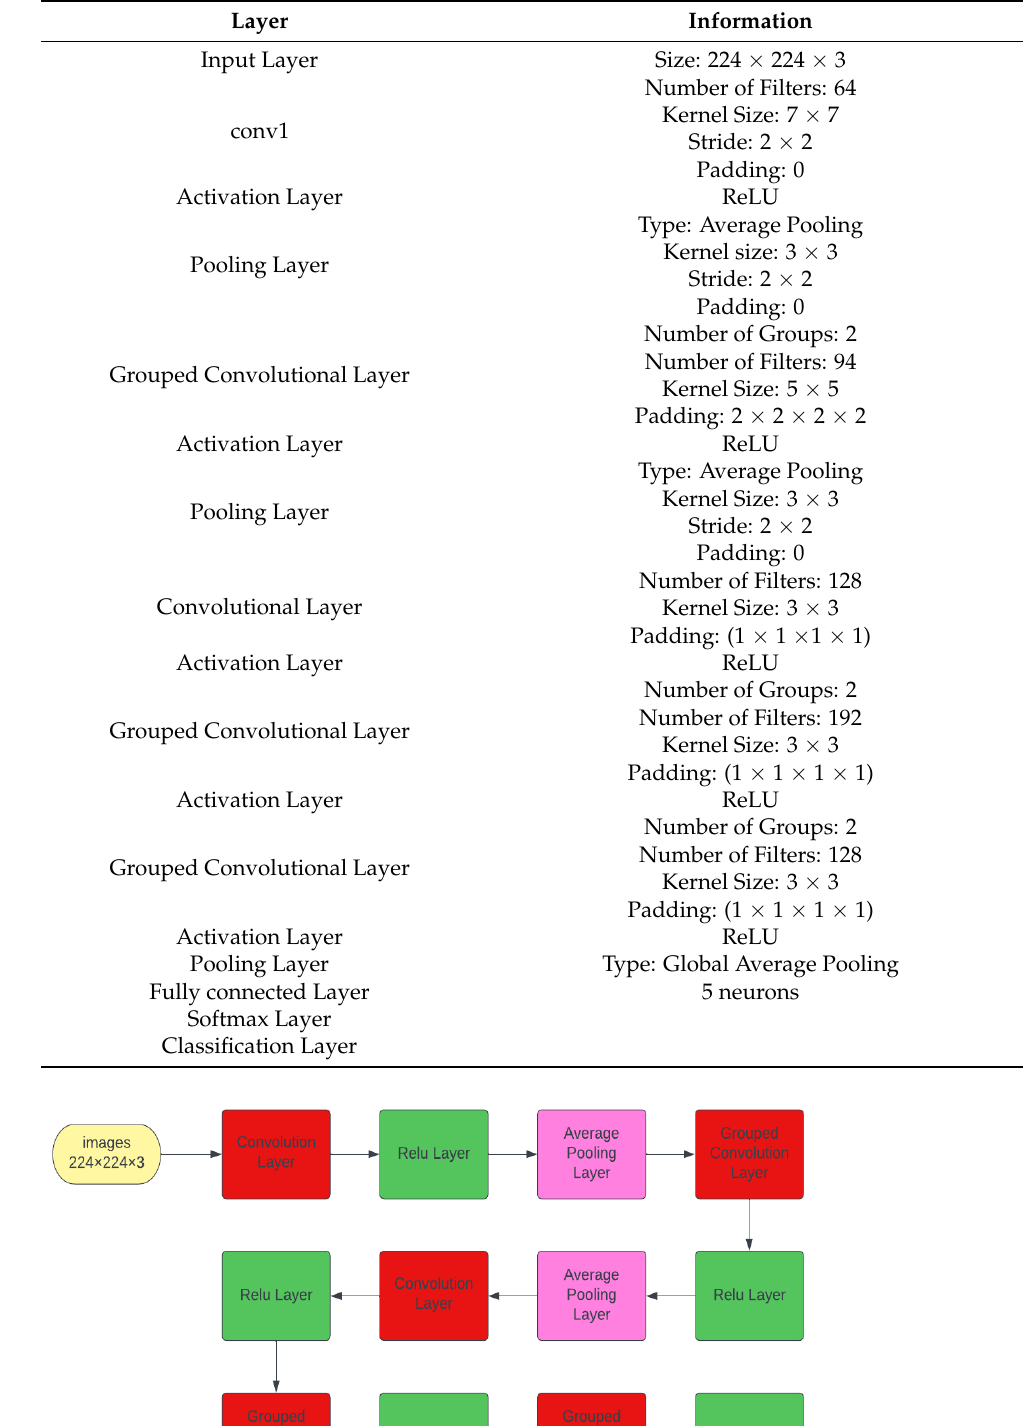
Table 2. Structure summaries of Cervical Net.